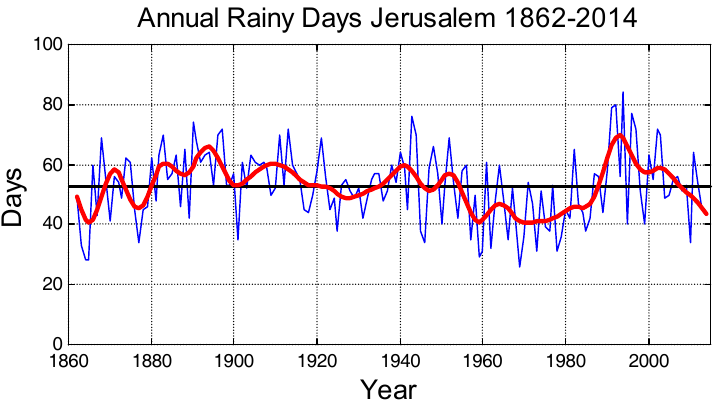
Figure 7. Time series of the number of the rainy days occurred in Jerusalem in the month of December, from 1862 to 2014 (153 years). The smoother (red) curve is the result of filtering the original time series by cancelling the components with period less than 10 years. For rainy days the average value is 52.7 days, the standard deviation is 11.9 days.